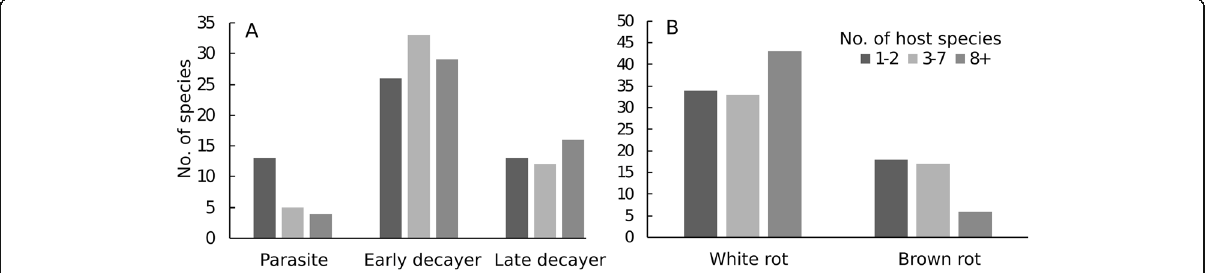
Fig. 4 No. of host tree species listed for wood-inhabiting polypore species with > 10 records in Estonia by life strategy ( a ) and by decay type ( b ). The categorization for each species given in Additional file